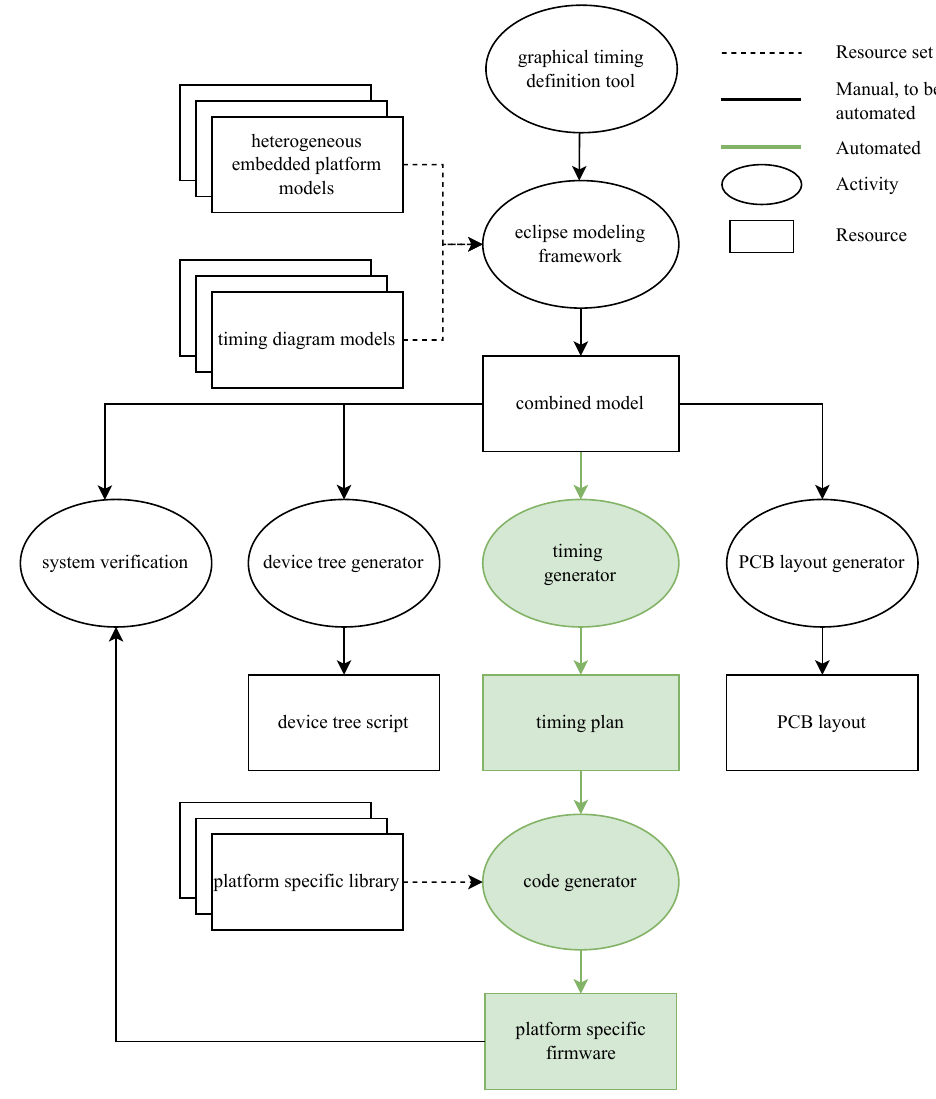
Figure 2. Proposed workflow for a model-based code generator for control systems. To begin, the user defines or selects two models, one for the desired embedded platform and one for the desired acquisition or actuation sequence. These two models are then automatically combined and used in a model-to-text transformation that generates a timing plan combining the requirements from the two models. This timing plan is then automatically combined with the minimal platform-specific library and compiled with a platform-specific compiler to generate a functional firmware, as explained in Section 3. An evaluation of a functional firmware generated by the framework can be found in Section 4. The parts that are currently not automated are identified as future work in Section